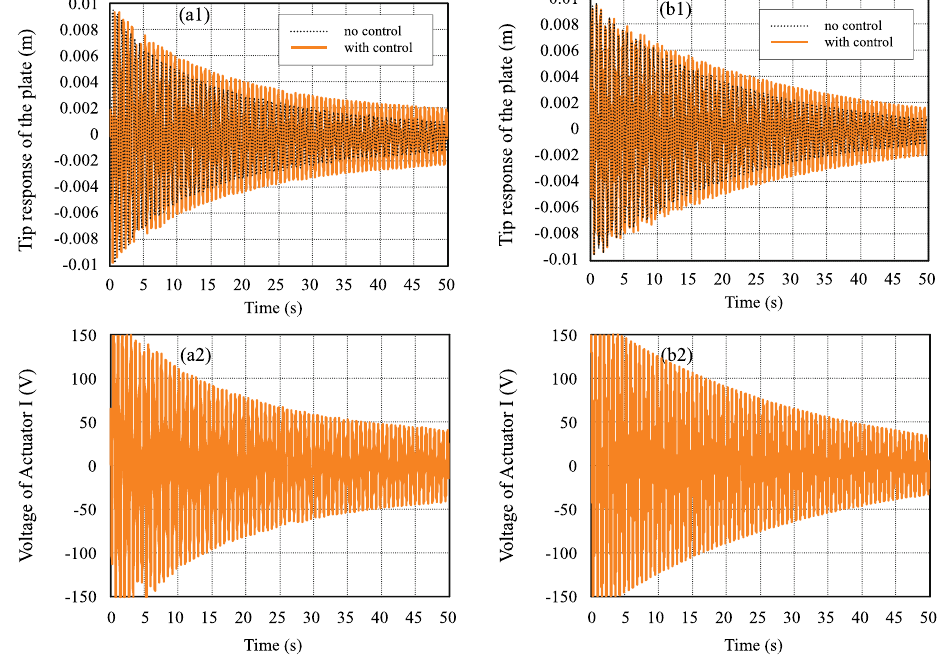
Fig. 6. Response of the plate and applied voltage of Actuator I when K = [1 . 4542 , 35 . 0246] is used for the plate with time delay (one actuator case): (a) experimental result ( τ = 0 . 08 s ), (b) simulation result ( τ = 0 . 09 s